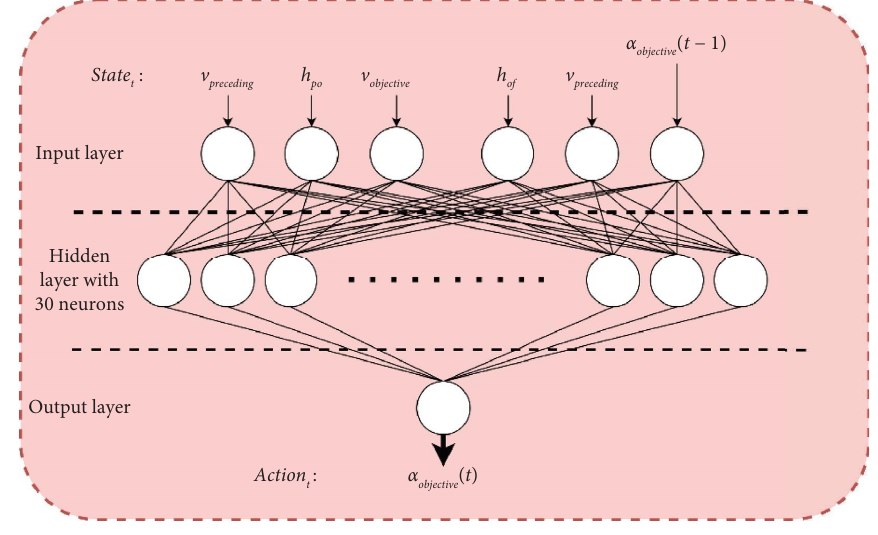
Figure 5: Structure of actor network.